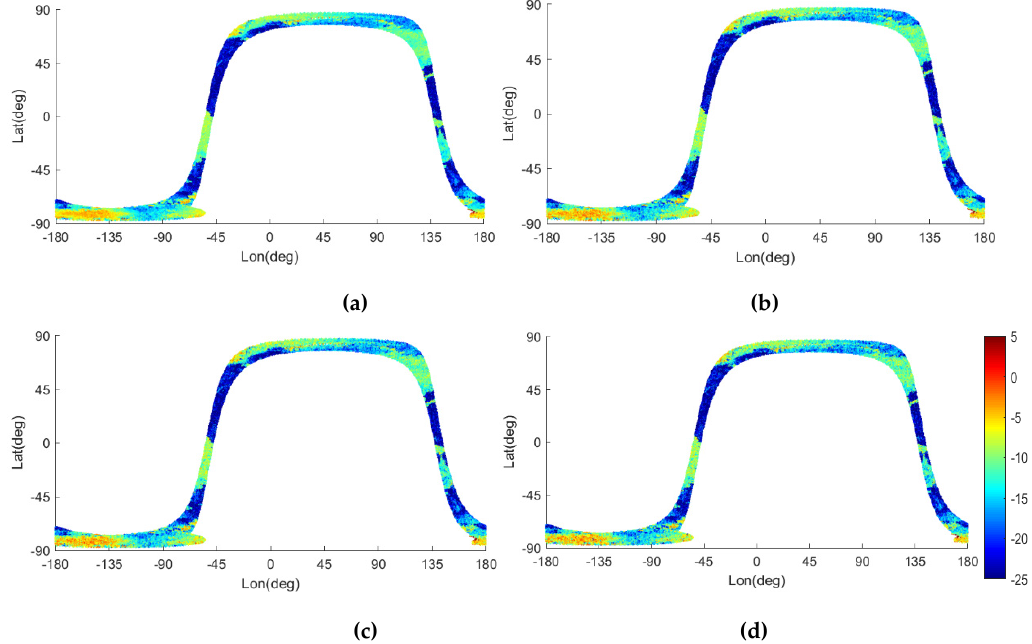
Figure 5. Ground level 1 (L1) product ( a ) and on-board normalized radar cross section (NRCS) distributions in LUTs for geolocating and X-factors in full resolution ( b ); half number resampled ( c ) and a quarter number resampled ( d ). Color indicates NRCS values in dB.